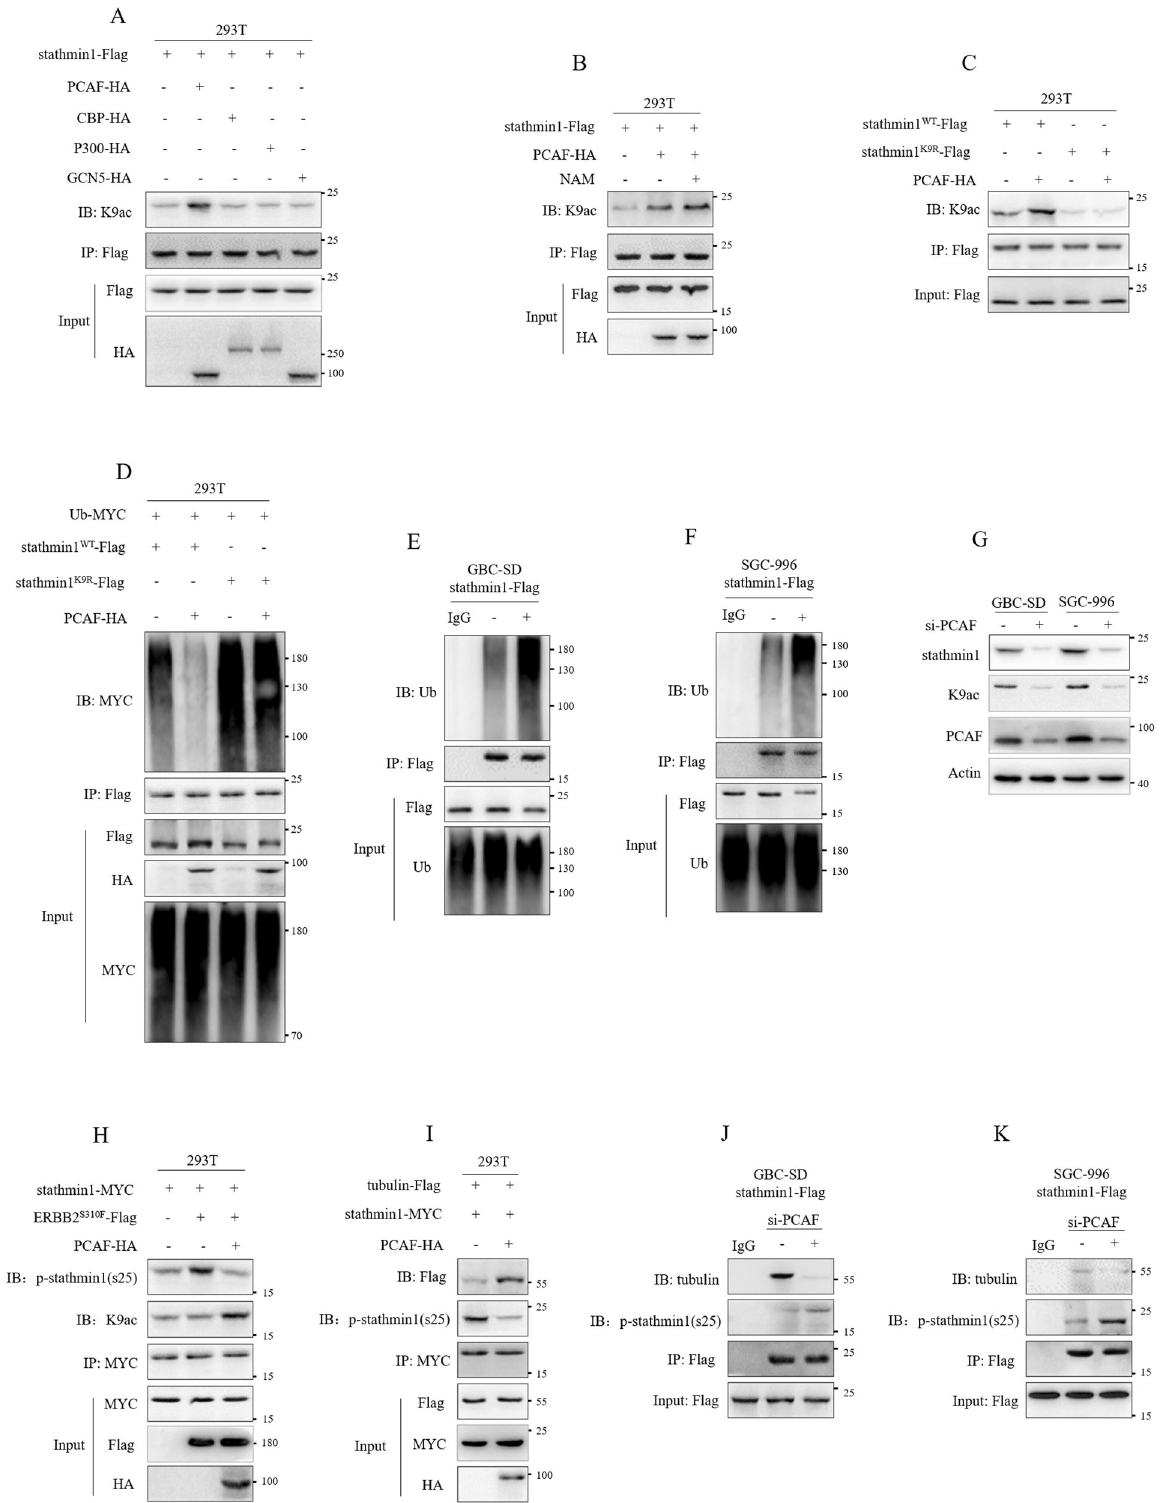
We next analyzed the deacetylase. Results from NAM treatment indicated the deacetylation of stathmin1 was regulated by SIRT family. According to the localization of seven SIRT family members [14, 18], we co-transfected the sirt1-HA, sirt2-HA, sirt3-HA, sirt5-HA and stathmin1-Flag plasmids to 293 T cells and con fi rmed